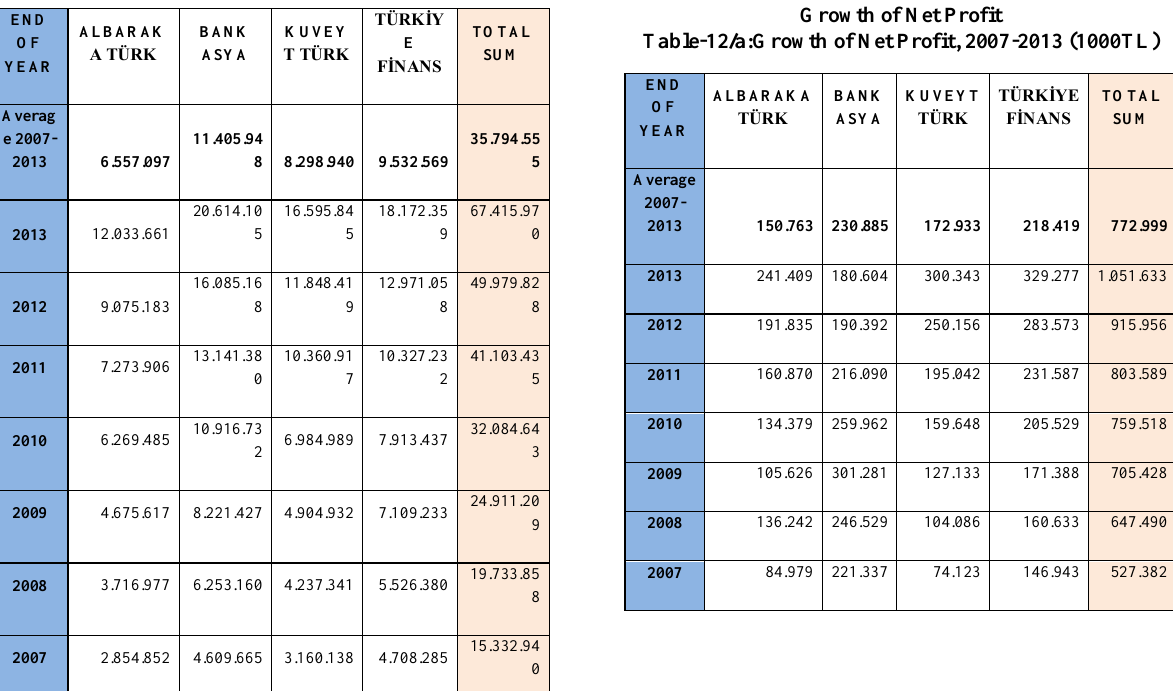
Table-11/b: Funds Utilized by Participation Banks 2007-2013 (1000TL)